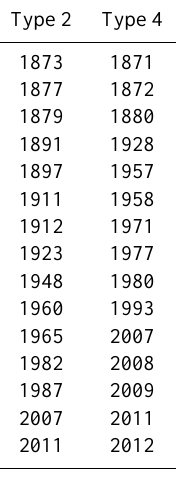
Table 1. For the SLP-based circulation types, which show a fre- quency increase over the 2007–2012 period, the summers present- ing a higher frequency than the 90th percentile frequency (i.e. a 10- year return period) on the basis of the 20CRv2 reference run over 1871–2012 (JJA) are listed